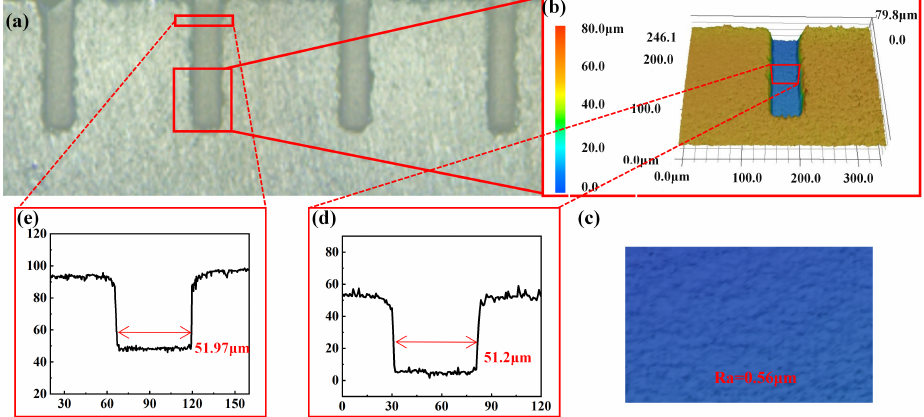
Figure 6. ( a ) Top view of the fabricated blind hole. ( b ) Three-dimensional local enlarged view of side section. ( c ) The enlarged view of the bottom of the blind hole. ( d , e ) The cross–section of the side